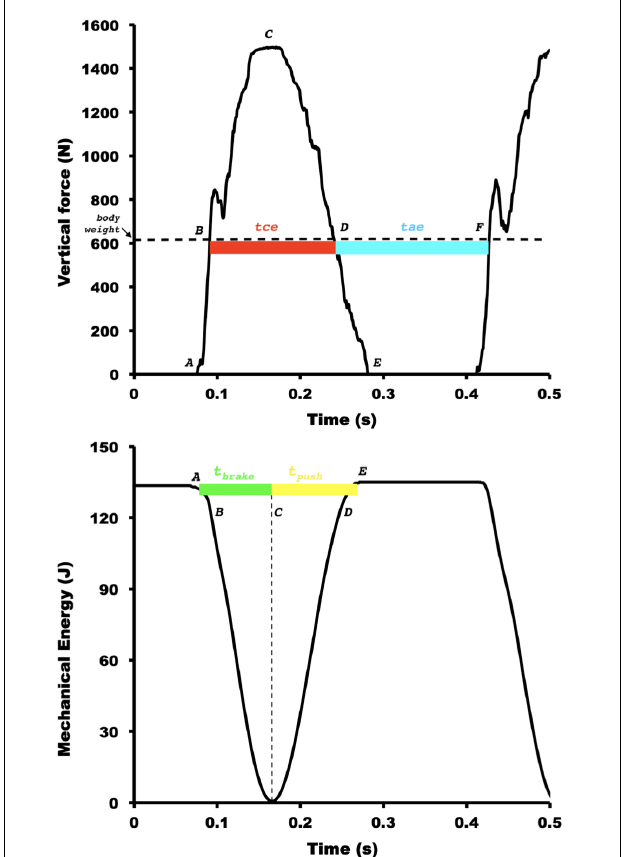
FIGURE 1 | Representative figure for the vertical ground reaction force, external mechanical energy, and two main temporal asymmetries during running at 13 km h − 1 . The letters indicate the discrete points defining the main phases of spring-mass model: ( A ) landing, ( B ) downward equilibrium point (instant where body weight equals to vertical ground reaction forces (GRF) during downward trajectory of the body), ( C ) maximal vertical force and transition between negative and positive work, ( D ) upward equilibrium point (instant where body weight equals to vertical GRF during upward trajectory of the body), ( E ) takeoff, ( F ) second downward equilibrium point. The effective contact time ( t ce , B – D , in red) and the effective aerial time ( t ae , D – F , in blue) represent the asymmetry of rebound. The positive work time ( t push , C – E , in yellow) and negative work time ( t brake , A – C , in green) represent the landing-takeoff asymmetry. The horizontal dashed black line in the superior panel denotes the body weight. The vertical dashed black line in the inferior panel indicates the transition instant between negative and positive